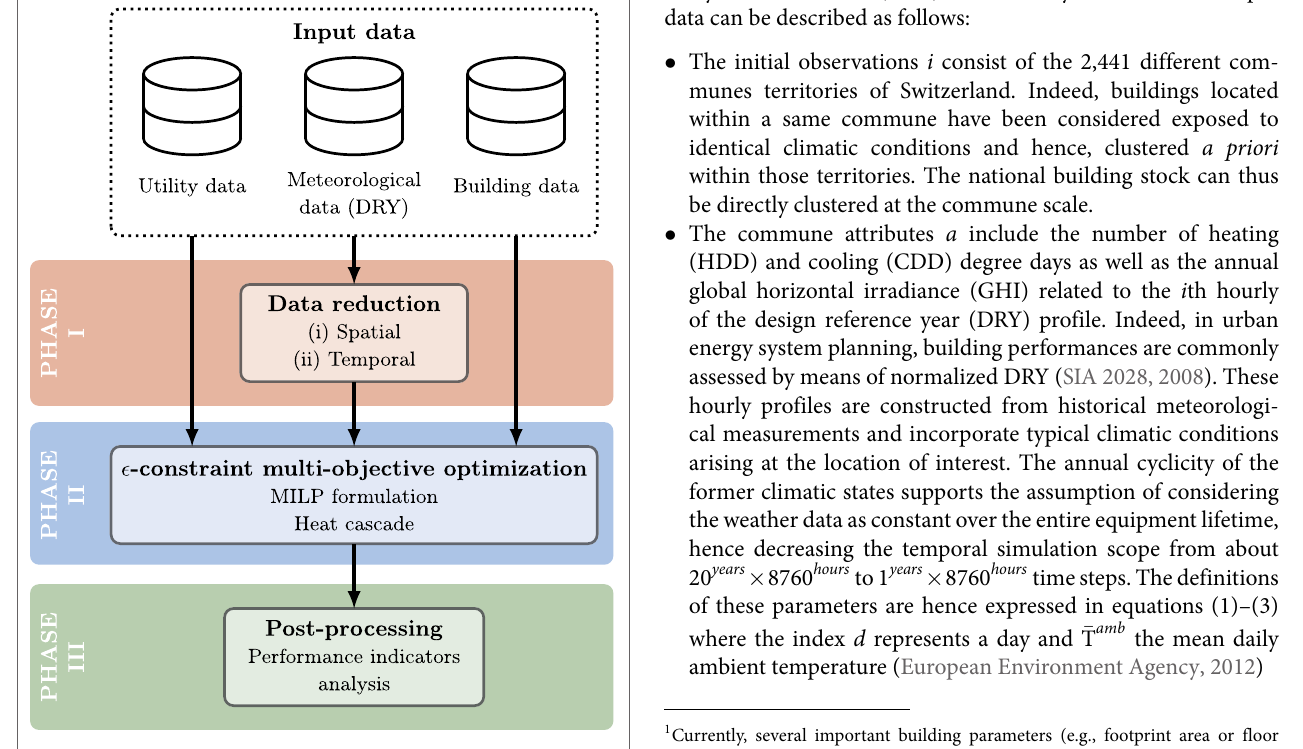
FIGURE 1 | Illustration of the developed